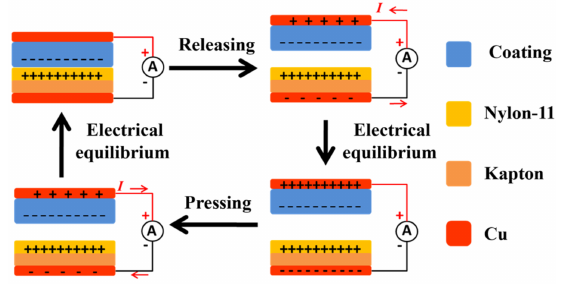
Figure 2. Schematic of the TENG’s electricity-generating